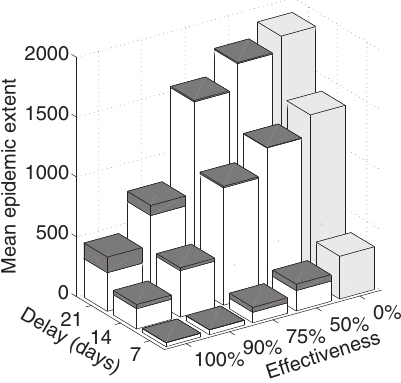
Figure 7. Sensitivity analysis for disease control parameters. Sensitivity of epidemic extent (i.e., number of counties infected) to changes in the delay to implementation and effectiveness of movement bans (i.e., proportion of movements from an area that are stopped). Bars give the mean extent for epidemics begun in the 5% of counties that generate the largest uncontrolled epidemics (as depicted in Figure 5A). The white bars represent a state-level ban while the dark gray bars show the additional epidemic extent if only a county-level ban were introduced. The light gray bars show the no movement ban case.